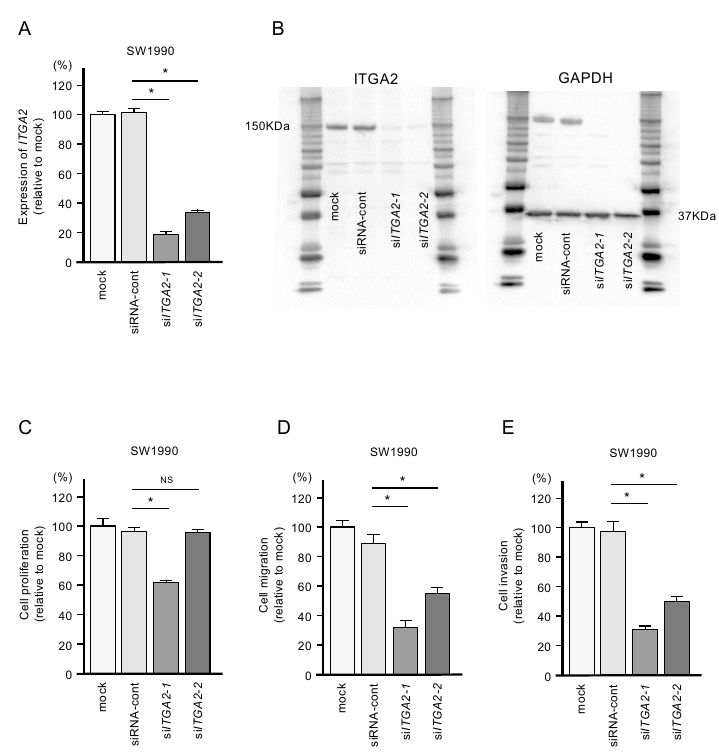
Figure 8. Effects of ITGA2 knockdown in SW1990 cells. ( A ) mRNA and ( B ) protein expression levels of ITGA2 by transfection with two types of si ITGA2 in SW1990 cells. ( C,D,E ) Cell proliferation, migration and invasion assays in SW1990 cells. (* p < 0.0001)